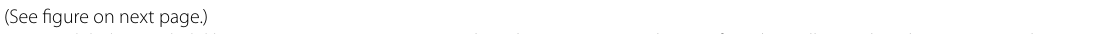
Fig. 4 Globuligerina balakhmatovae (Morozova). Nos. 1, 4a, b and 5, cuttings sample 8360 ft., Eider well, Grand Banks, Bajocian-Bathonian; wall texture varies from relatively smooth to densely pustulose, with pustules merging into short ridges. No. 2, sample 24/2P, Tojeira Formation, Montejunto, Portugal, lower Kimmeridgian; wall texture coarsely pustulose. No. 3, swc sample 5000 ft., Bittern well, Grand Banks, Callovian—early Oxfordian; note the coarse pustulose test and oblong chambers, final one becoming pointed. Nos. 6, 7, 8, 9, 10 and 11 side, umbilical and spiral views of co-types of Globuligerina balakhmatovae (Morozova) in the type section for this taxon from sample 8, Parkinsonii Zone, Upper Bajocian,